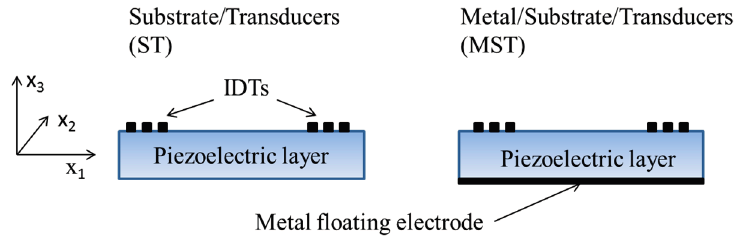
Figure 1. Cross sections of the Substrate/Transducer (ST) and Metal/Substrate/Transducer (MST) coupling